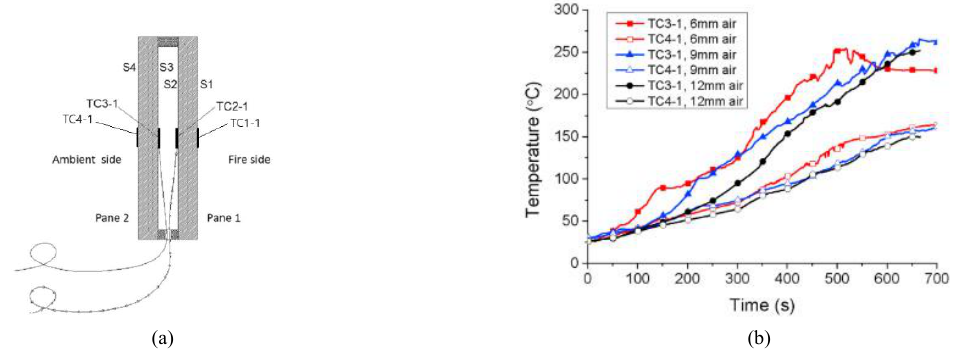
Fig. 15 (a) The cross-section of the double glazing and (b) the temperature variation of pane 2 for every air space thickness (Wang et al.